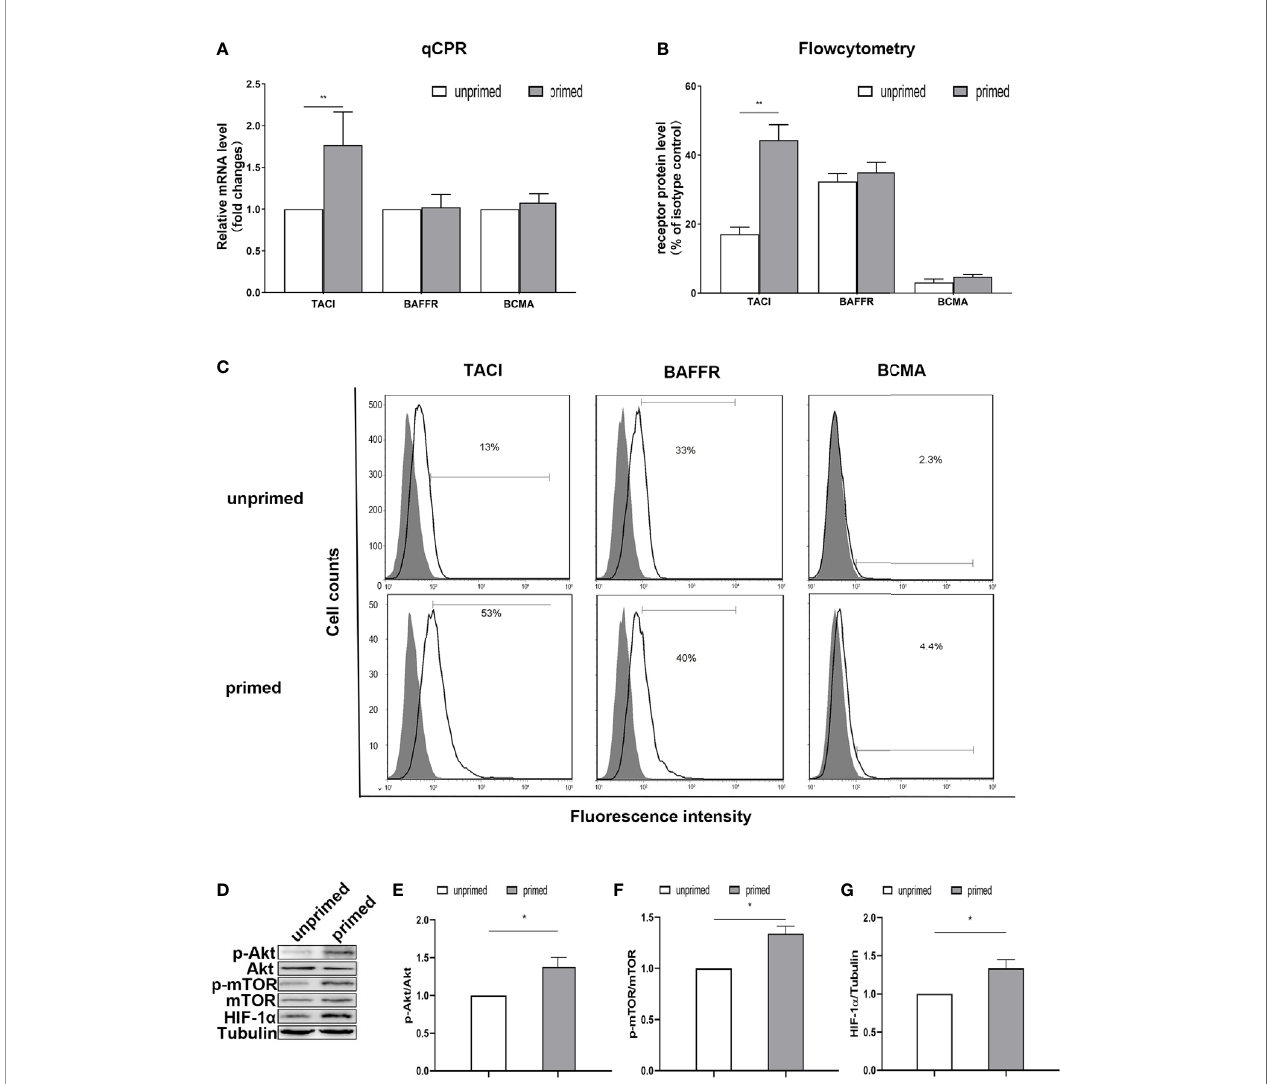
FIGURE 5 | TACI and Akt/mTOR/HIF-1 a signaling were involved in BAFF priming of BV2 cells. BV2 cells were primed with 10ng/ml BAFF or vehicle for 24 h. (A) RNA was collected and the relative mRNA expression of TACI, BAFF-R, and BCMA, relative to GAPDH, are assessed in BV2 cells by quantitative real-time PCR. (B, C) The expression of BAFF receptors on the surface of microglia was detected by fl ow cytometry. BV2 cells are stained with primary antibodies for TACI, BAFF- R, and BCMA (solid lines without fi lling) or an isotype control Ab (solid lines fi lled with gray). (B) The graph represents the relative fl uorescence intensity of the primary antibody subtracting its isotype control antibody. (D) 6 days after BV2 cells were primed by BAFF or vehicle, whole-cell extracts were collected and levels of Akt, p-Akt, mTOR, p-mTOR, and HIF-1 a were detected by western blot. Densitometric quanti fi cation of p-Akt/Akt (E) , p-mTOR/mTOR (F) , and HIF-1 a /tubulin (G) in (D) . Data are mean ± SEM (n = 9); Kruskal-Wallis test with Turkey post hoc test; *p < 0.05, **p < 0.01 compared with